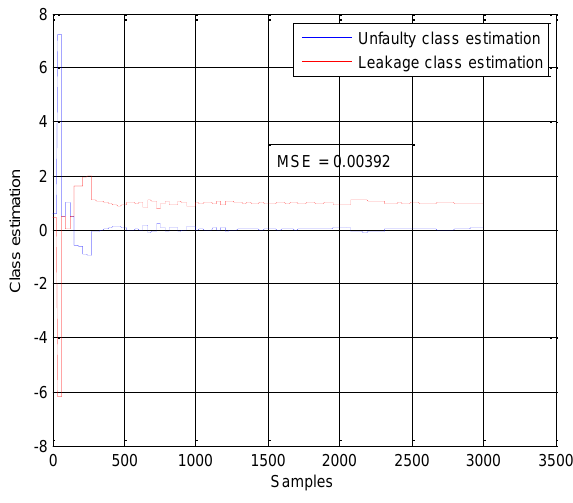
Figure 5. Engine_speed = 1000 rpm and torque = 110 Nm.